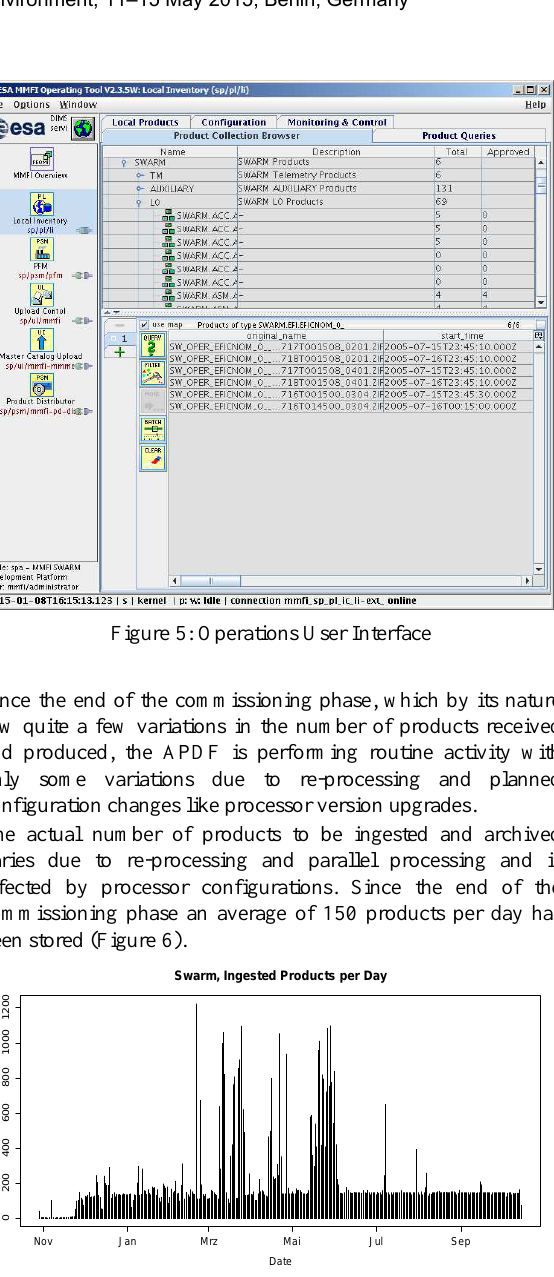
Figure 6: Ingested Products per